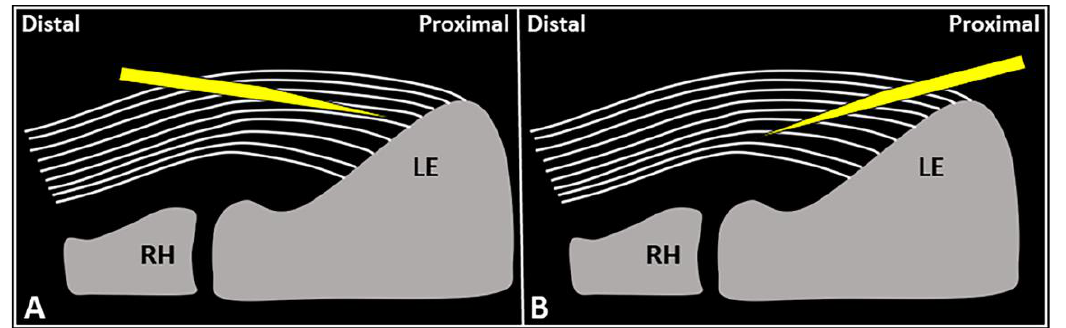
Figure 4. Schematic drawing shows the distal-to-proximal ( A ) and proximal-to-distal ( B ) approaches for performing USG fenestration of the CET. While the needle tip ( yellow ) can slip in between the tendon fibers ( white lines ) in the former technique ( A ); crossing in an orthogonal fashion, it efficiently disrupts them in the latter ( B ). RH: radial head, LE: lateral epicondyle.